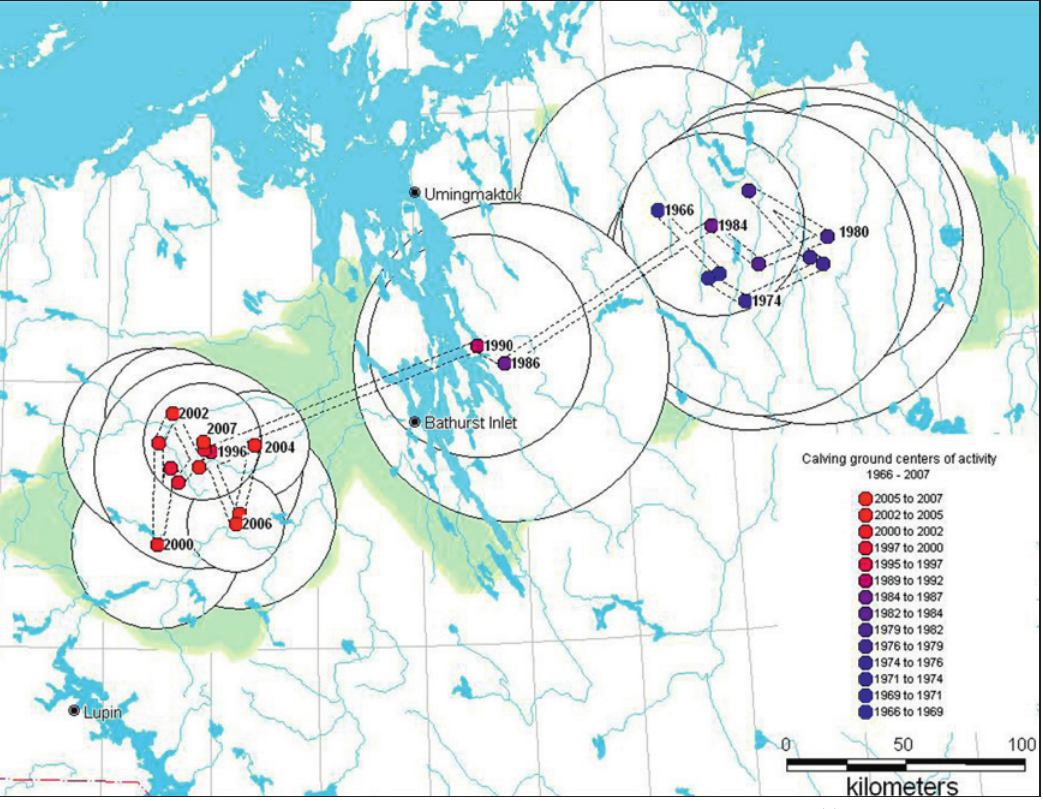
Fig. 2. Centroids of annual calving grounds at the peak of calving for the Bathurst herd, 1966 to 2007. The centroids are embedded in circles that are equivalent to the area of the annual calving ground; larger circles denote larger annual calving grounds (see Gunn et al., 2008 for further